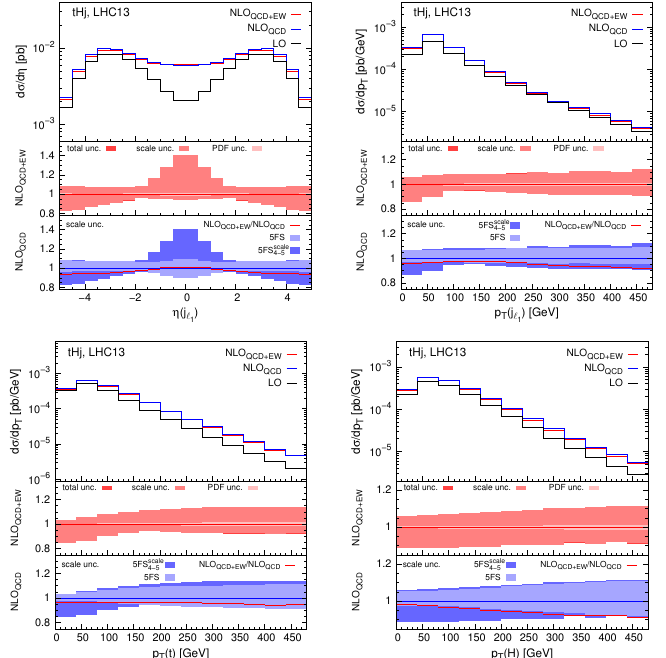
Figure 4 . NLO QCD+EW predictions for tHj . In each plot the (cid:12)rst inset shows the total uncertainty ((cid:13)avour-scheme, scale and PDFs) and the second inset shows the NLO QCD+EW = NLO QCD ratio along with the NLO QCD scale uncertainties both in the 5FS scale and 5FS. 4 (cid:0) 5 comparing the LO and NLO lines in the main panel. For more details on this e(cid:11)ect QCD see appendix A in ref.